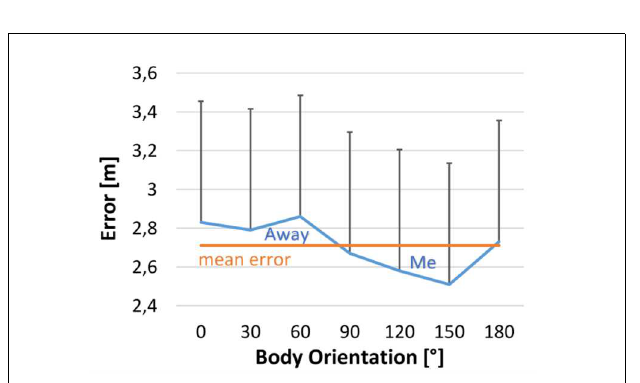
FIGURE 6 | Distance estimation error as a function of body orientation. Left and right turns were